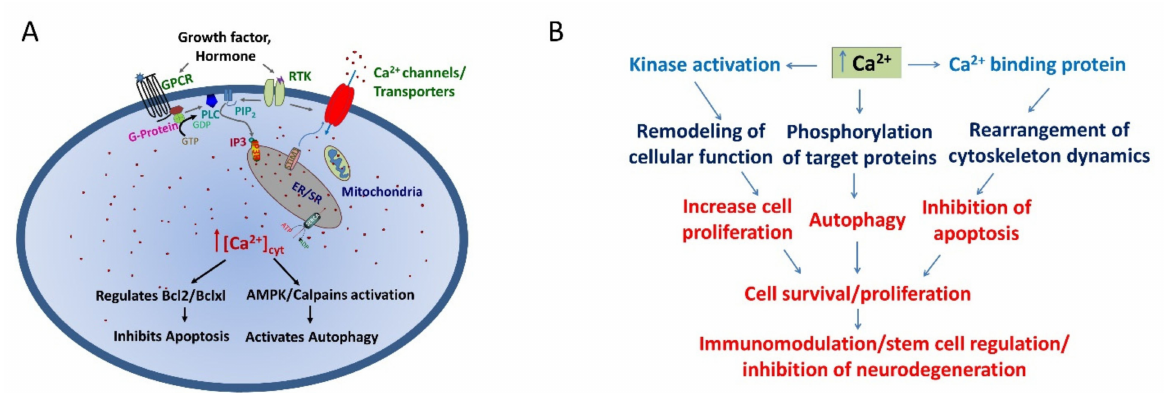
Figure 1. Ca 2+ signaling and its function in cell survival. Model showing the common Ca 2+ signaling pathways is shown in ( A ). Cells have several mechanisms for regulating cytosolic Ca 2+ concentration. The activation of G coupled protein receptor (GPCR or receptor tyrosine kinase (RTK) complex activates PLC, which catalyzes the dissociation of PIP2 to form diacylglycerol and IP 3 . IP 3 binds to its receptors in the ER (IP 3 R), resulting in the release of the stored Ca 2+ from the ER. Emptying of the ER Ca 2+ activates the STIM protein to translocate to the PM and binds to Ca 2+ channels (TRPCs/Orais). Activation of these Ca 2+ channels or regulation of other Ca 2+ channels (TRPs and voltage gated channels) increases cytosolic calcium levels that maintains autophagy and inhibits apoptosis. ( B ) Summary of the pathways that are activated upon increase in cytosolic calcium levels is shown in the schematic